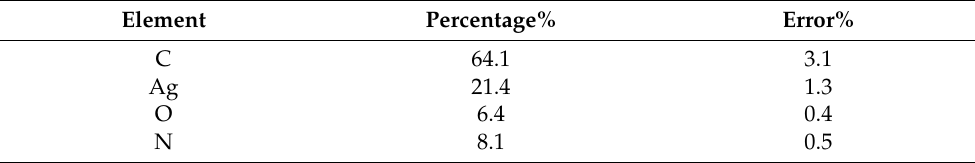
Figure 7. ( a ) XPS survey of the produced AgNPs; ( b ) Ag 3d; ( c ) C 1s; and ( d ) N 1s X-ray photoelectron spectra of AgNPs. Table 2. Surface elemental composition of AgNPs.